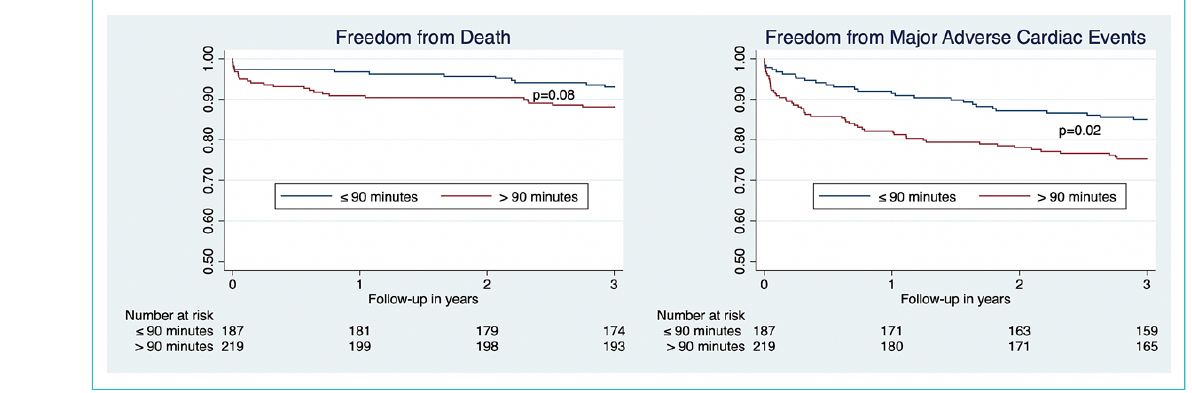
Figure 2: Kaplan-Meier curves for survival free from the occurrence of major adverse cardiac events and